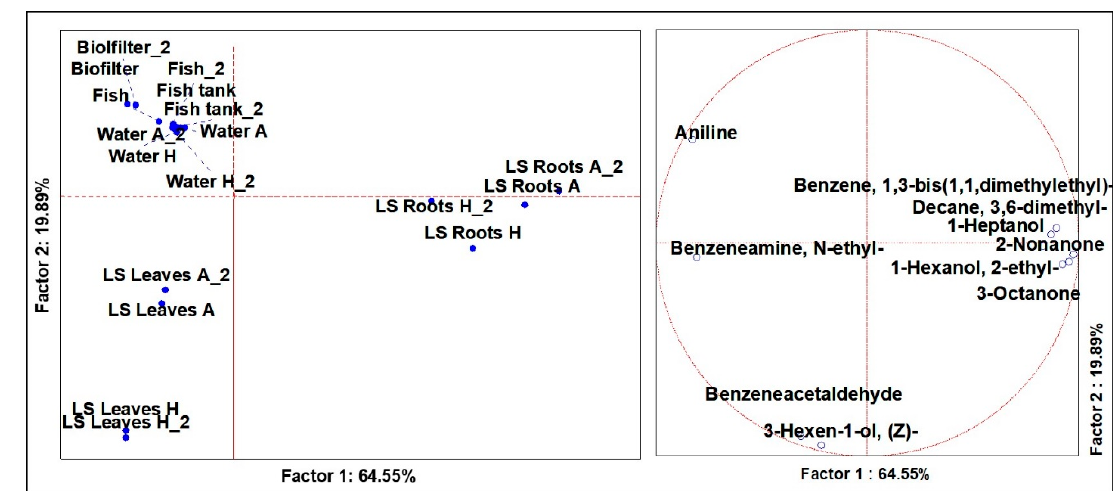
Figure 2. Principal component analysis (PCA) of the cases ( left ) and variables ( right ) of the significant (ANOVA p < 0.05) VOCs of Lactuca sativa .